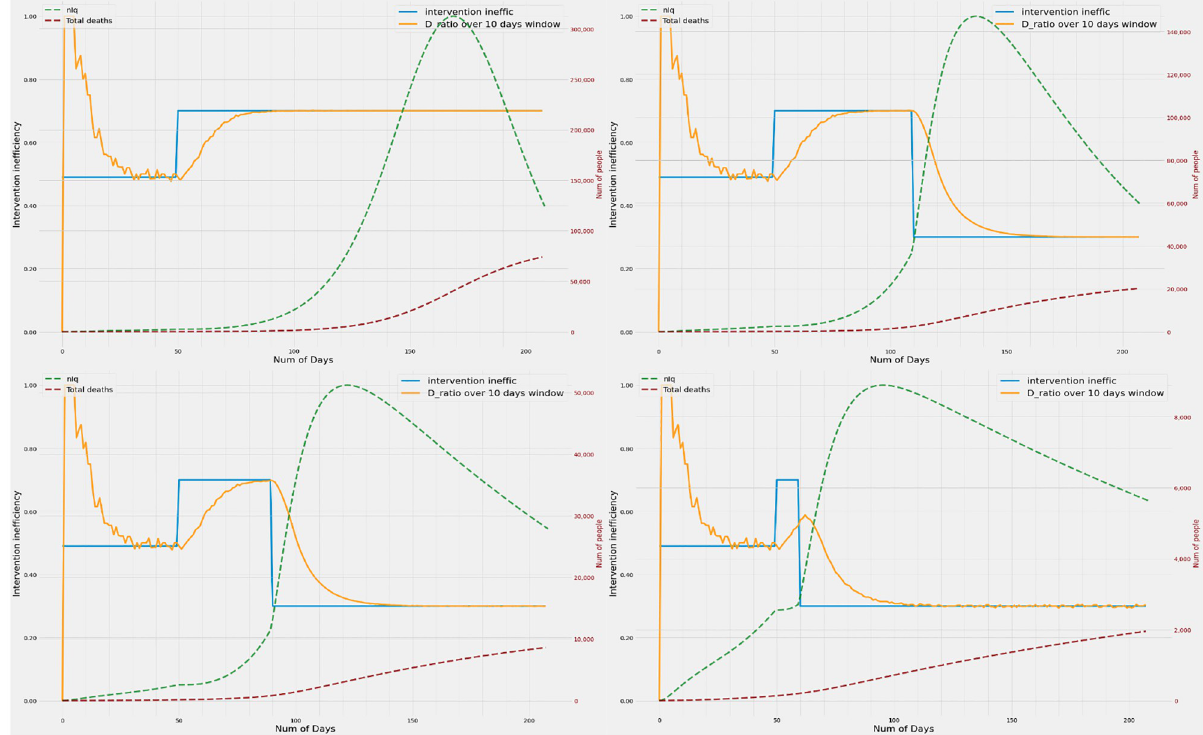
Fig 5. Left to right: (a) Inefficiency increases, but no counter measures are taken. Result is a peak active case load of 300 000 in a 10 million population and causing close to 75 000 deaths. (b) Inefficiency is lowered when the daily active cases significantly increase above 40,000. This measure reduces the daily active cases by nearly 50% and deaths by 75%. (c) By monitoring rise in daily active cases closely, lowering the inefficiency when they rise above a smaller threshold of 15 000 active cases daily, the peak and deaths both reduce considerably. (d) Instead when the inefficiency is lowered as the D ratio begins to increase, the peak active cases and deaths are